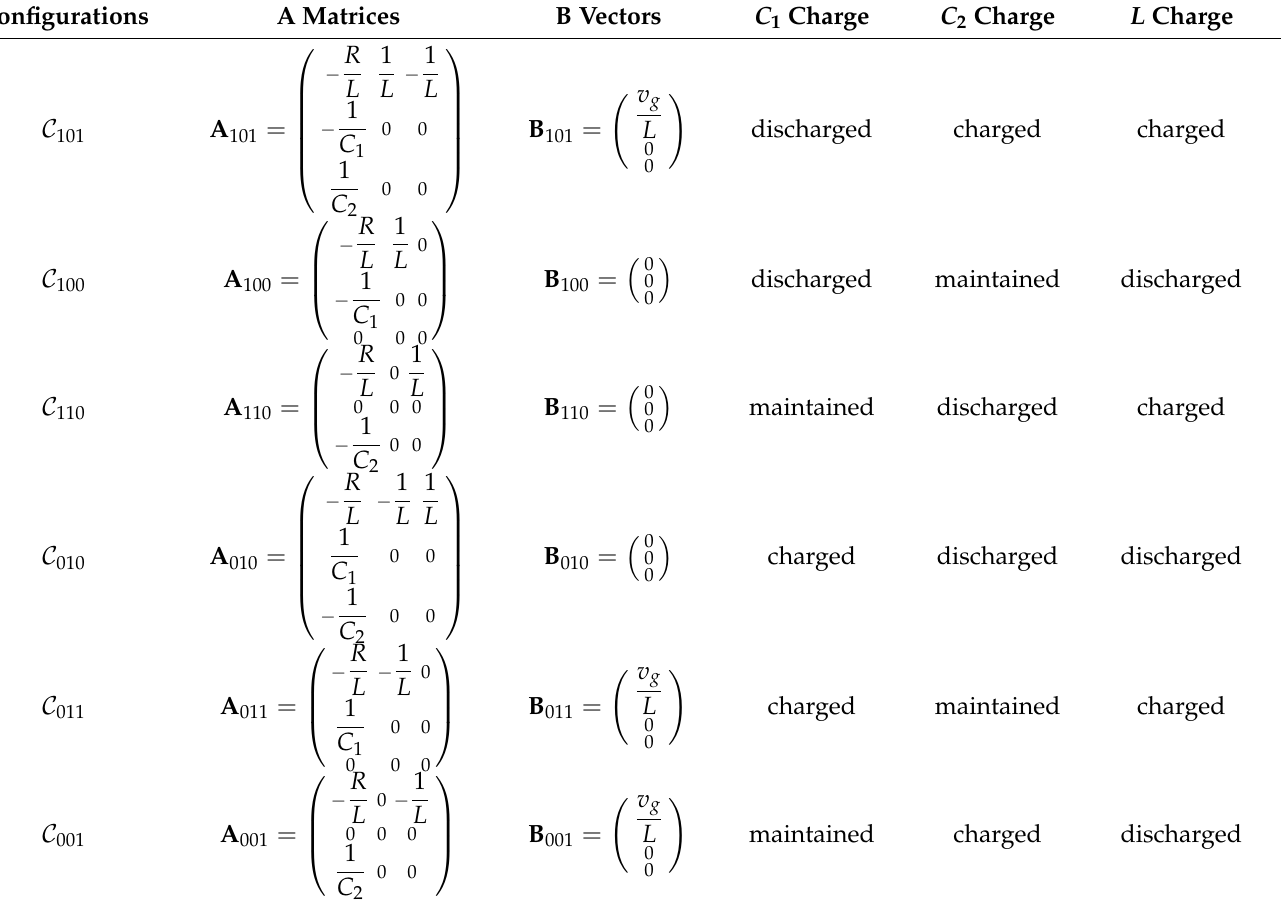
Table 1. Matrices for the eight different